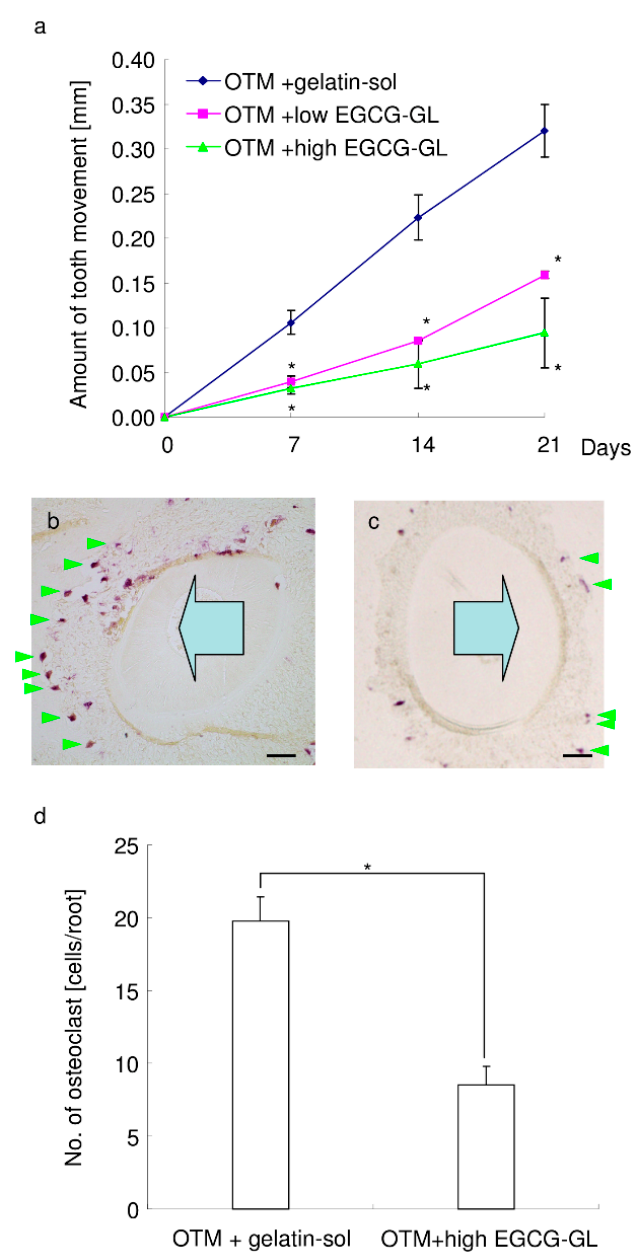
Figure 8. A local, single EGCG-GL injection inhibited the rate of orthodontic tooth movement (OTM) via attenuation of osteoclastogenesis. ( a ) The amount of tooth movement of the OTM + gelatin solution group (blue), OTM + low EGCG-GL group (pink), and OTM + high EGCG-GL group (green). *: p < 0.05 versus OTM + gelatin solution group. (n = 4, 4, and 5 for OTM + gelatin solution group, OTM + low EGCG-GL group, and OTM + high EGCG-GL group, respectively.) ( b , c ) Representative photographs of TRAP staining in the OTM + gelatin solution ( b ) and OTM + high EGCG-GL ( c ) groups. Arrowhead indicates osteoclasts on the alveolar bone surface. The large arrow indicates the direction of orthodontic tooth movement. Bar: 100 µ m. (n = 4 and 5 for OTM + gelatin solution and OTM + high EGCG-GL, respectively.) ( d ) The number of osteoclasts on the alveolar bone surface at the compression side of mesial root of M1. *: p < 0.05 between groups.